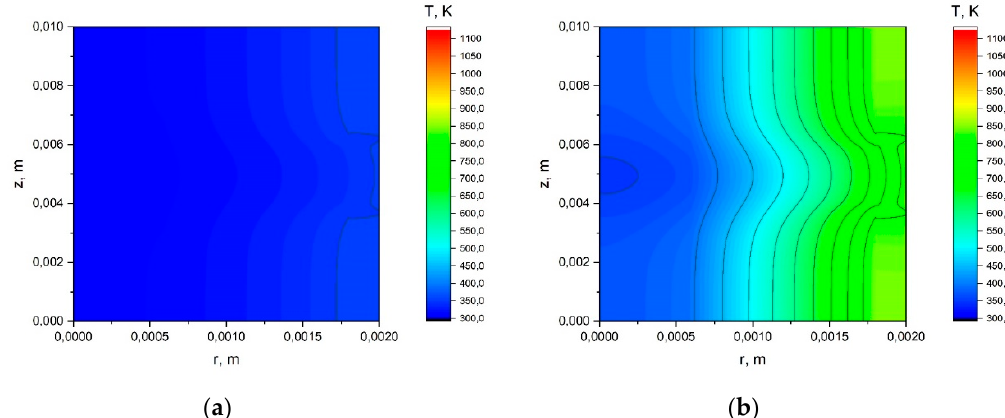
Figure A17. Temperature distribution in the stem of a herbaceous plant: R = 0.002 m, t = 3 s, q = 3 kW/m 2 ( a ); R = 0.002 m, t = 3 s, q = 30 kW/m 2 ( b ).